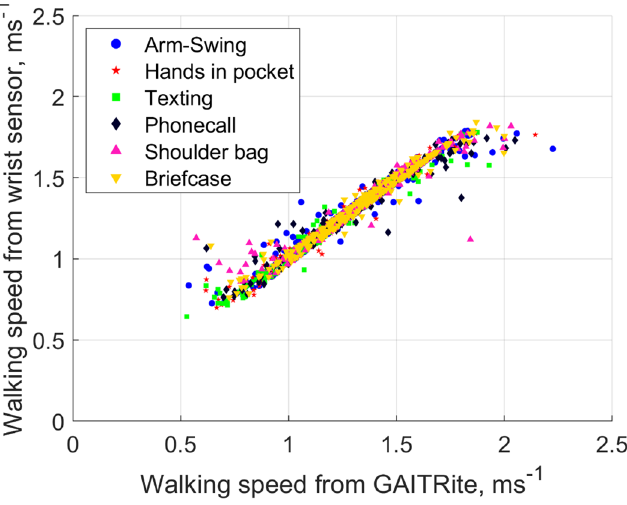
Figure 3. Relationship between wrist sensor and electronic walkway measured walking speed. N = 101 with 1487 walks. Each individual dot represents an individual data point. Combined data from six walking conditions.